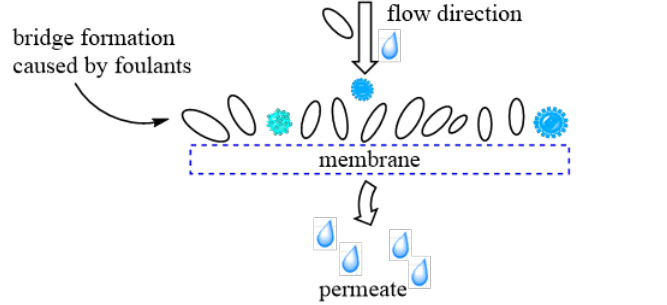
Figure 3. Membrane fouling mechanism during filtration [21].